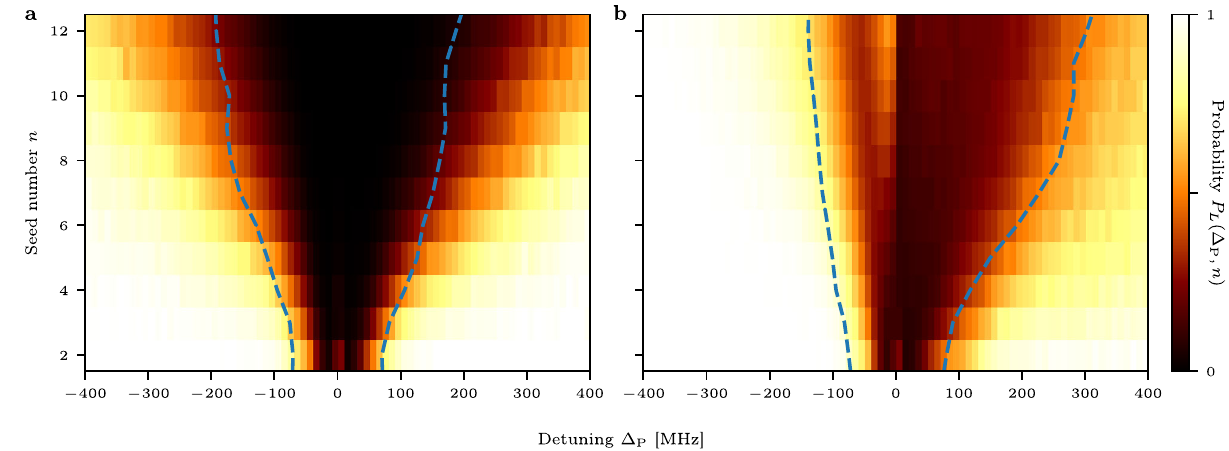
Fig. 3 Localization – delocalization crossover. We plot the probability P L ( Δ P , n ) to fi nd a localized state for ( a ) a pure random XY model and ( b ) with additional C 6 interaction between the seeds as realized in the experiment. The regime of predominantly delocalized states spreads for an increasing number of seeds n , shifting the localization--delocalization crossover to larger energies. The estimated energies Δ CO where the corresponding calculated spectra show a transition towards algebraic ∣ Δ P ∣ − 2 scaling are denoted by blue dashed lines. For a more detailed explanation of how Δ CO is determined from the individual calculated spectra, see Methods for a mathematical derivation and Supplementary Fig. 6 for a graphical representation.